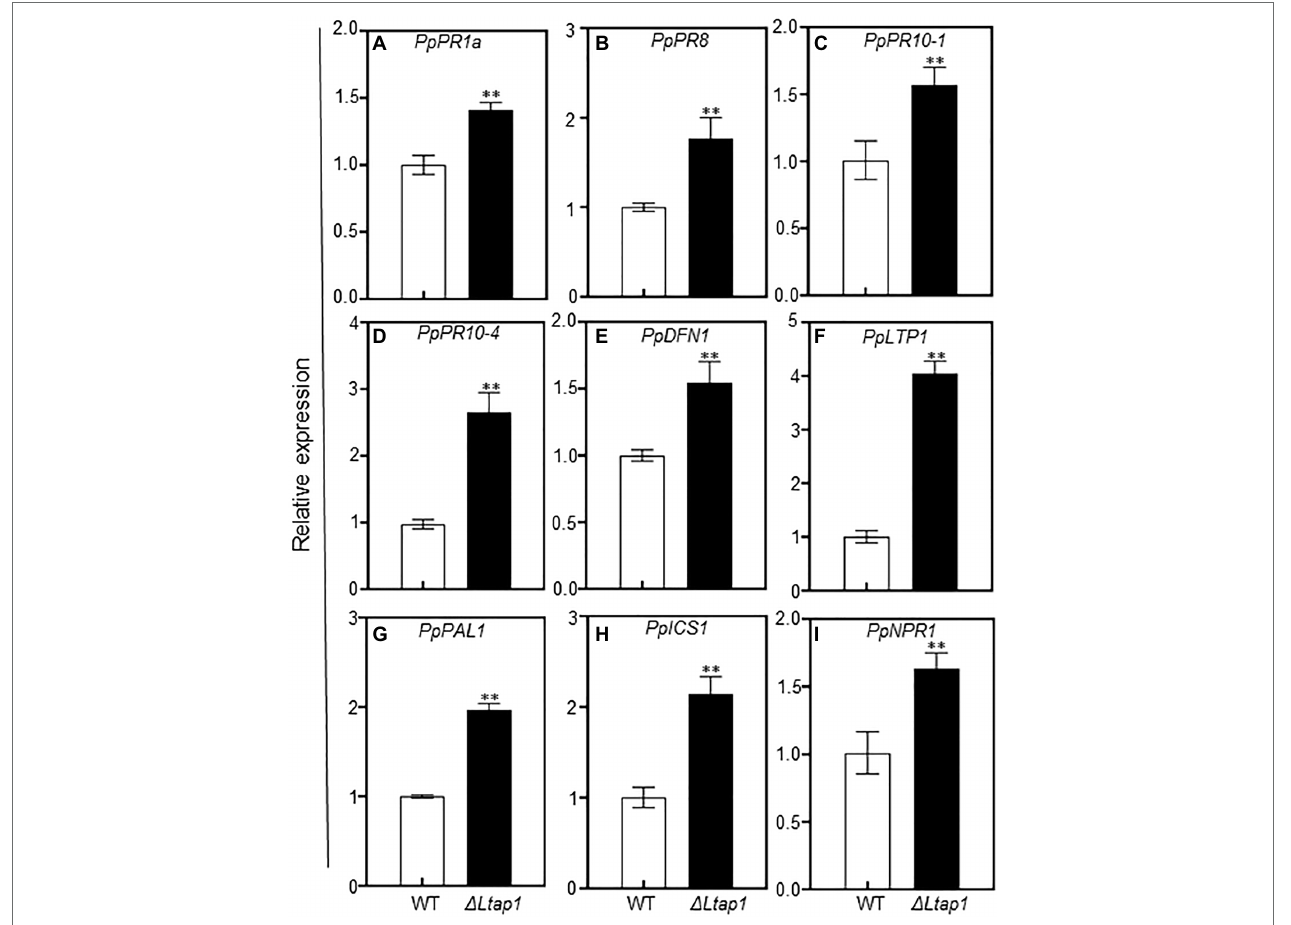
FIGURE 9 | Impact of LtAP1 deficiency on the transcripts of defense-responsive genes in infected peach shoots. RNA samples were collected from peach shoots inoculated with L. theobromae WT or Δ Ltap1 mutant at 5 dpi. (A–F) : The relative expression of pathogenesis-related ( PR ) genes, including PpPR1a , PpPR8 , PpPR10-1 , PpPR10-4 , PpDFN1 , and PpLTP1 . (G–I) : Expression pattern of SA biosynthetic ( PpPAL1 and PpICS1 ) and signaling ( PpNPR1 ) genes. Relative transcript levels of genes compared with that of the control using reference gene PpTEF2 for normalization. Values are means ± SD of three biological replicates. Asterisks indicate a significant difference between two genotypes for genes at p <